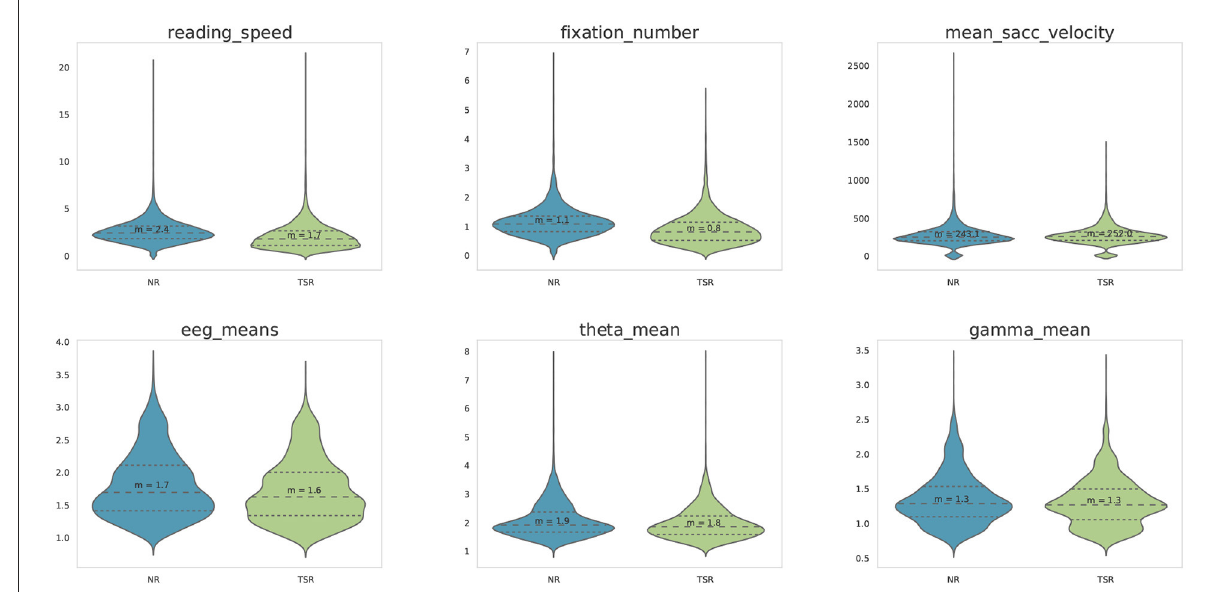
FIGURE6 Examples of feature distributions across all subjects for the NR and TSR sentences included in the ZuCo 2.0. dataset.